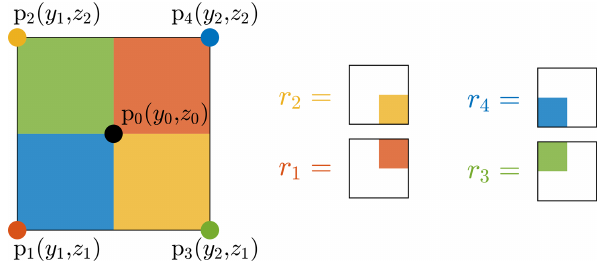
Figure 8. Visualization of 2D linear interpolation. The interpolated value at p 0 is calculated by the weighted mean of the values at neighboring grid points. The weighting factor r i for the value at the point p i is calculated according to the proportion of the partial area diagonally opposite the point p i to the whole area, which is shown with corresponding colors.